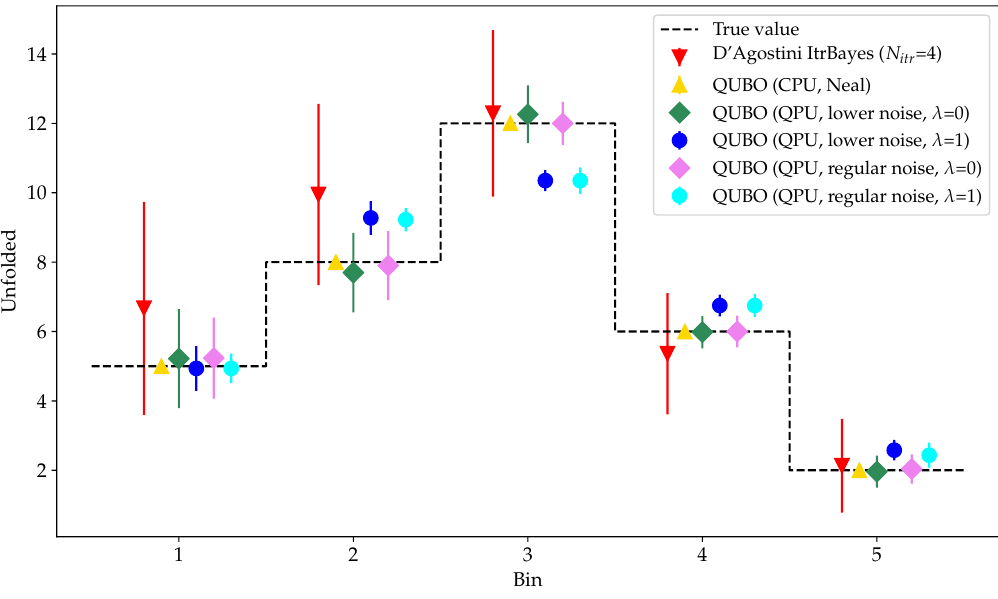
Figure 2 . Truth-level distribution of pseudo-data, unfolded with di(cid:11)erent methods, of a peaked spectrum. The data corresponding to runs submitted to the QPU are averaged over 20 executions with 5000 reads each.